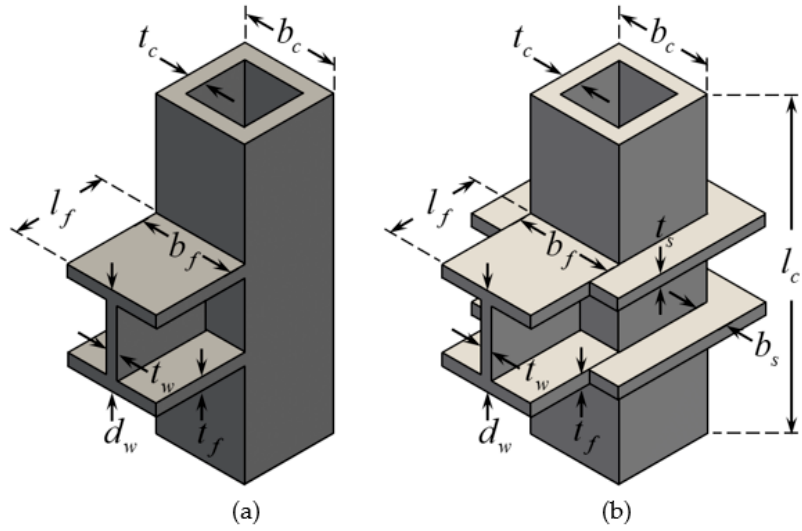
Figure 4. HSS column in an IBBC area—( a ) pre-retrofitting, ( b ) post-retrofitting.